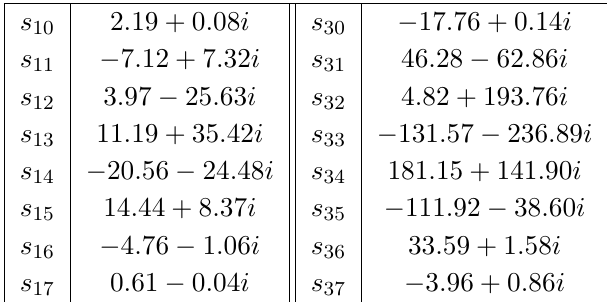
Table 2 . The fitting parameters at T = 0 . 1 GeV.